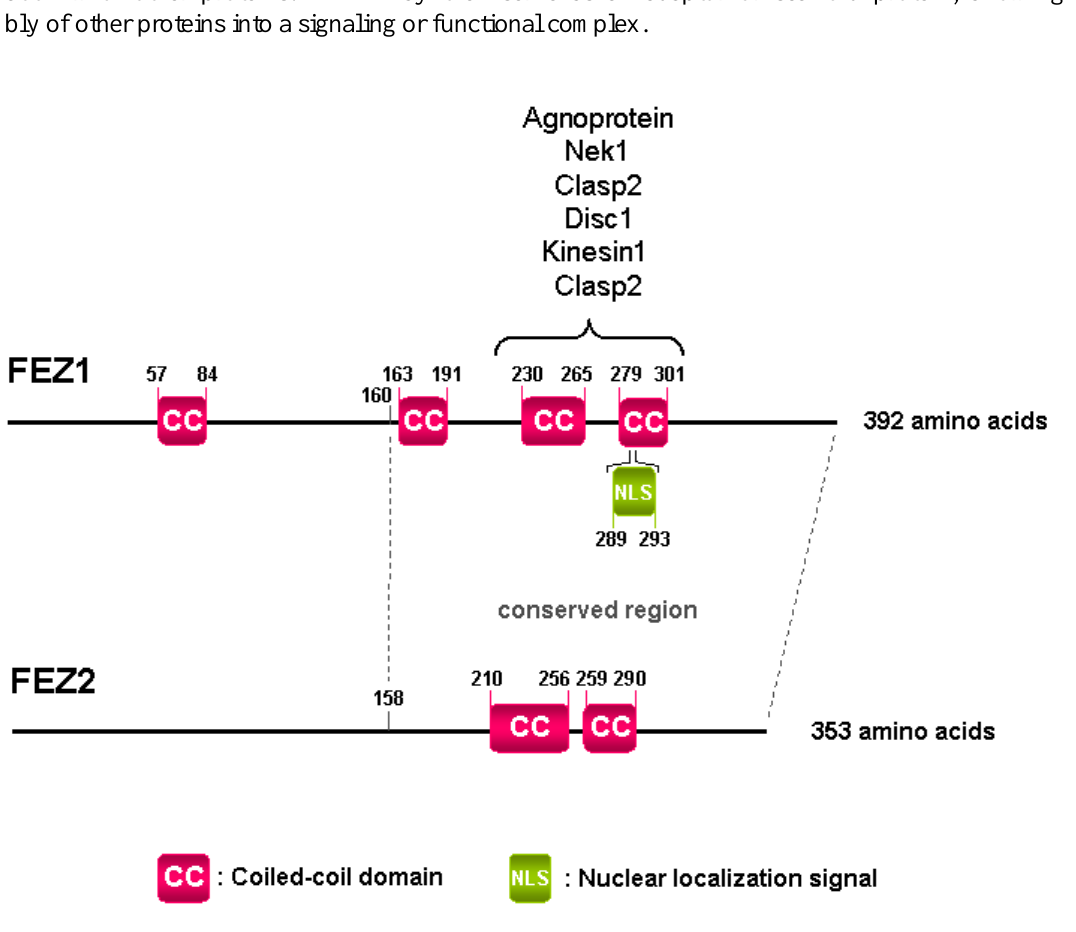
FIGURE 1. Schematic structures of human FEZ1 (GenBank accession number: AAC51282) and FEZ2 (GenBank accession number: BAD06207). Curly bracket indicates the region of FEZ1 involved in interaction with several